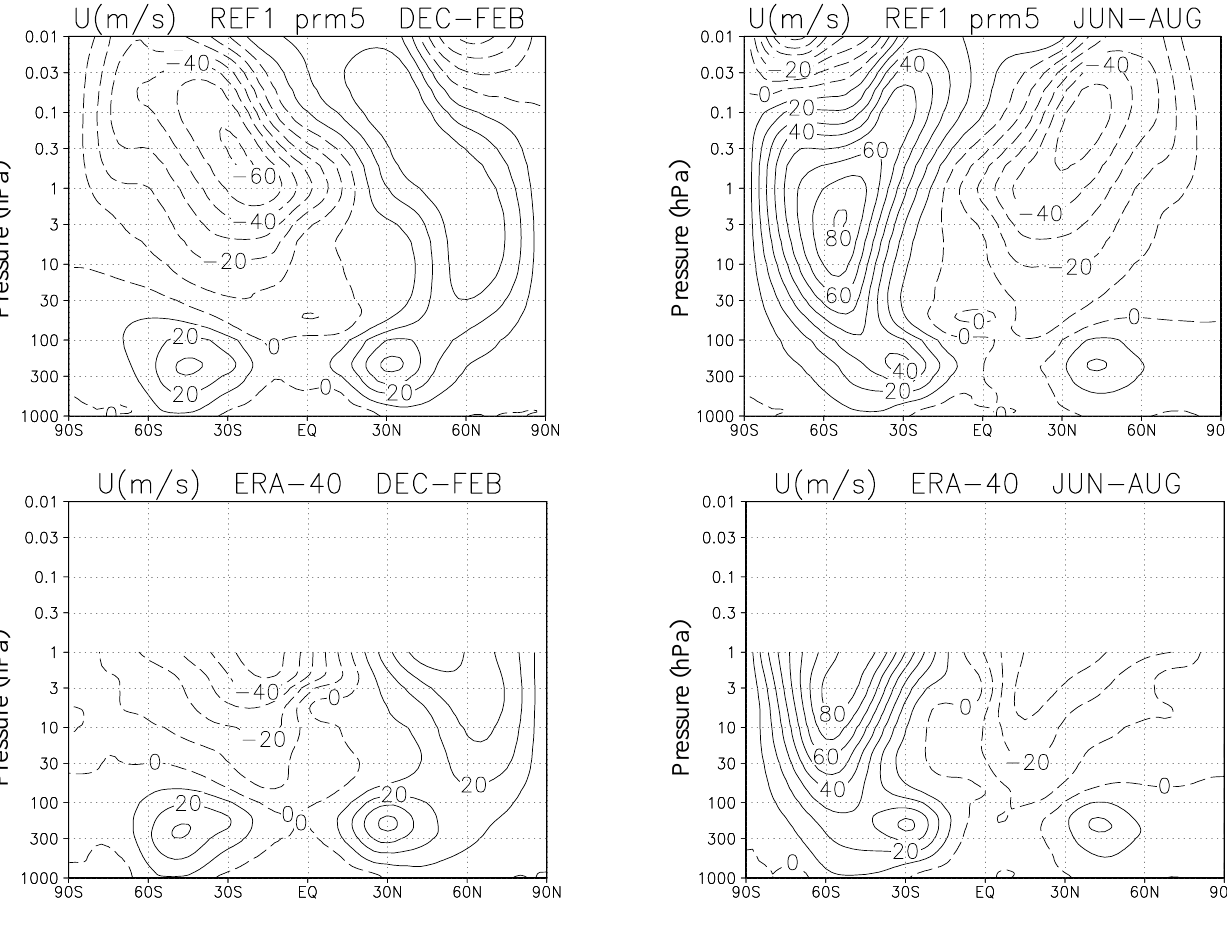
Fig.1a Latitude-pressure cross sections of 10-year averages of the seasonal- and zonal-mean zonal wind for the simulation (upper) and ERA40 (lower) during the 1990s (from 1990 to 1999). Left panel is for December to February and right panel for June to August. Contour intervals are 10 m/sec.